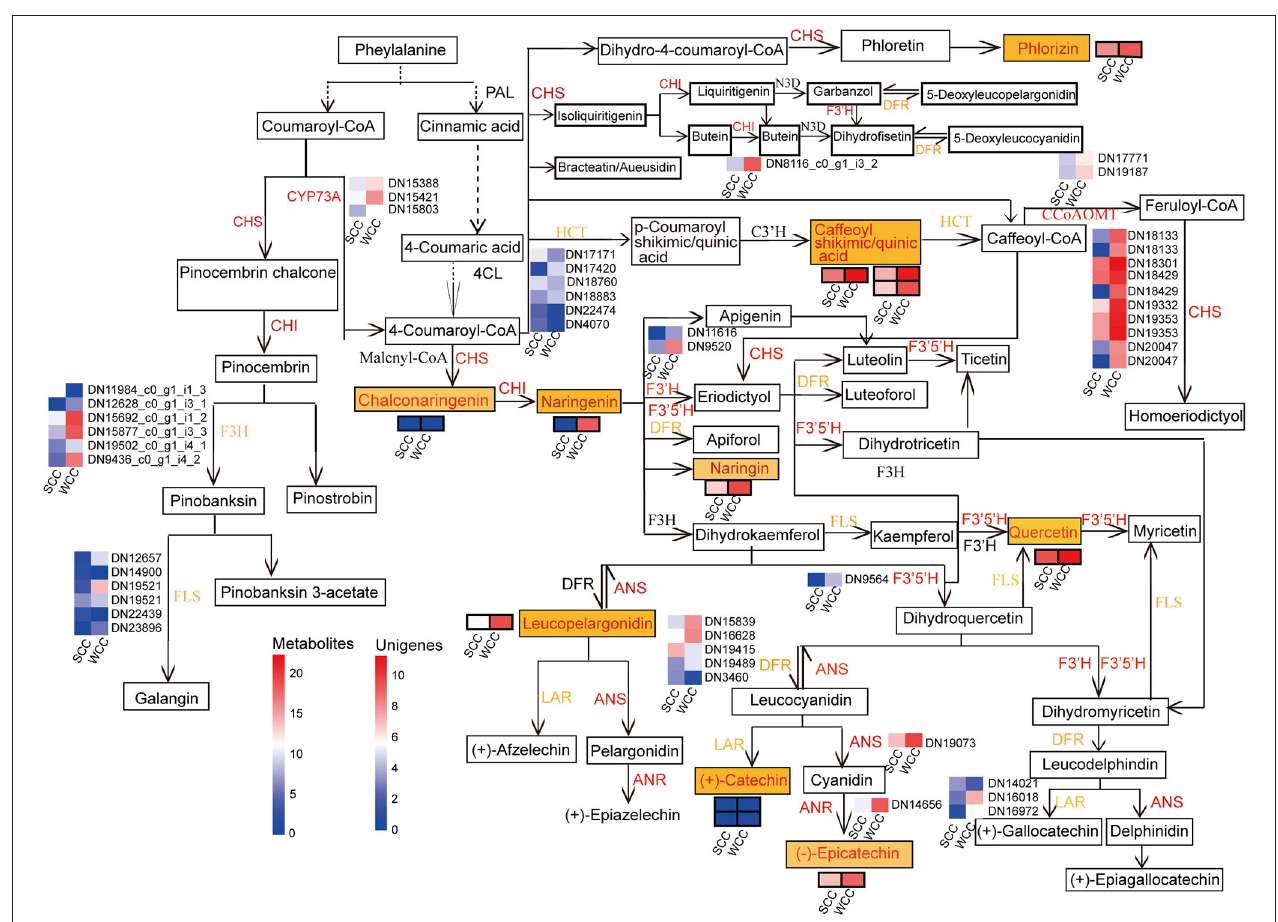
FIGURE 8 | Metabolic pathway map of the flavonoid biosynthesis pathway. SCC and WCC represent summer and winter Chinese cedar needle samples, respectively. Small squares without/with lines indicate the expressed levels of unigenes/metabolites, and red/yellow text indicates up/both up- and downregulated genes or metabolites in WCC needles. The abbreviation of each gene is as follows: A NR , anthocyanidin reductase gene ; ANS , anthocyanidin synthase gene ; CCoAOMT , caffeoyl CoA O-methyltransferase ; CHI , chalcone isomerase ; CHS , chalcone synthase ; CYP73A , cytochrome P450 ( CYP ); DFR, dihydroflavonol-4-reductase ; F3H , flavanone 3-hydroxylase ; F3’H , flavonoid-3’-hydroxylase ; F3’5’H , flavonoid-3’,5’-hydroxylase ; FLS , flavonol synthase gene ; HCT , hydroxycinnamoyltransferase ; LAR , leucoanthocyanidin reductase